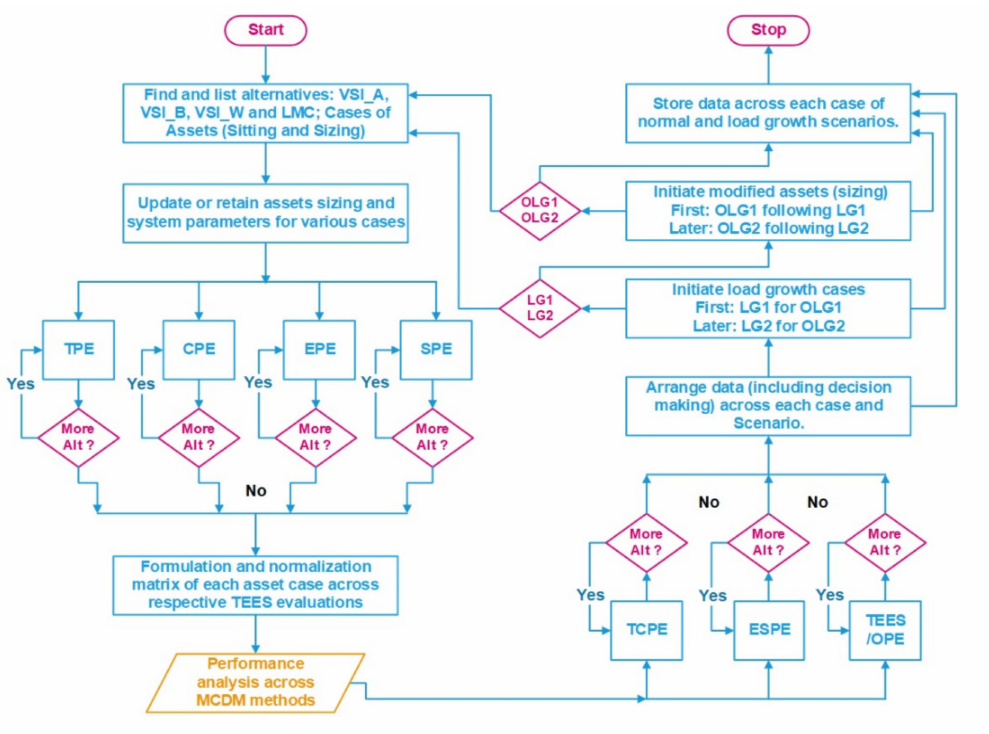
Figure 2. Flow chart of the proposed multi-criteria-based sustainable planning (MCSP)